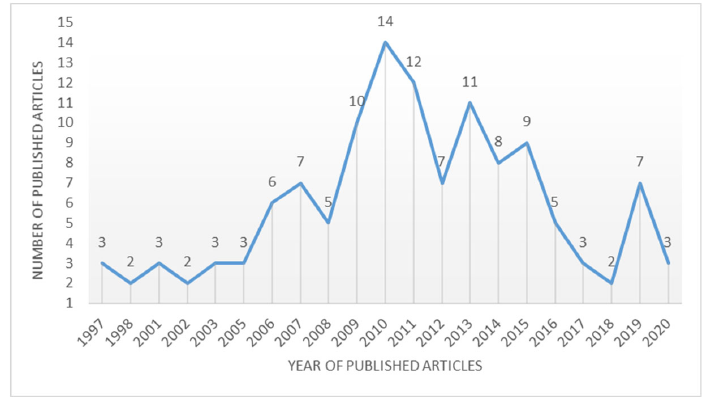
Fig. 1 . Frequency of titled RCPSP articles. It is obvious that researchers worked on the problem more in 2010 and 2011 than in other years, but the trend shows that it does not stop.